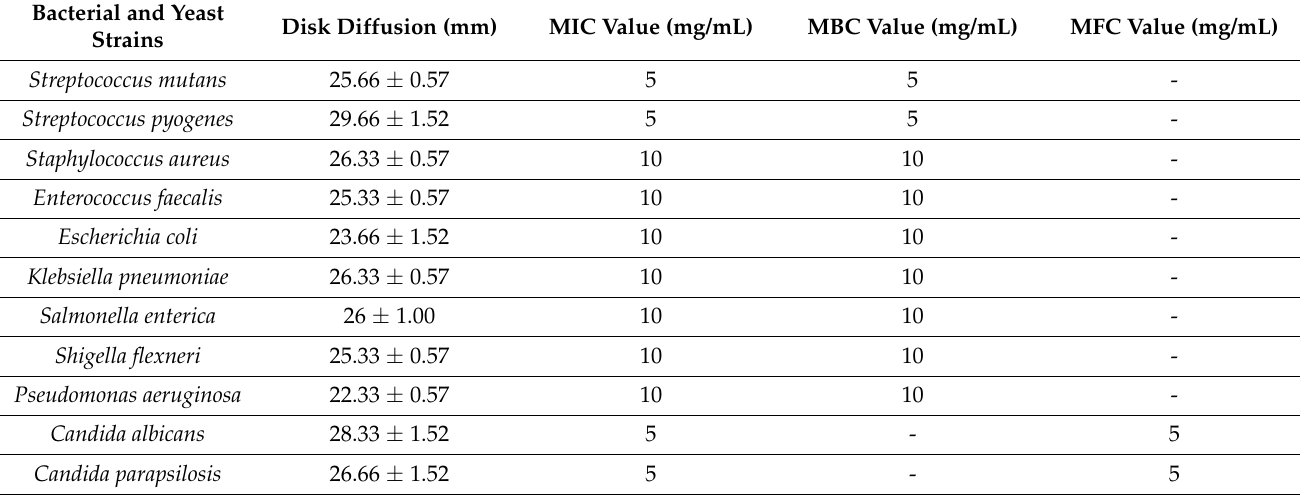
Table 3. Antimicrobial activity of the NEO by disk diffusion, minimum inhibitory concentration (MIC), minimum bacterici- dal concentration (MBC), and minimum fungicidal concentration